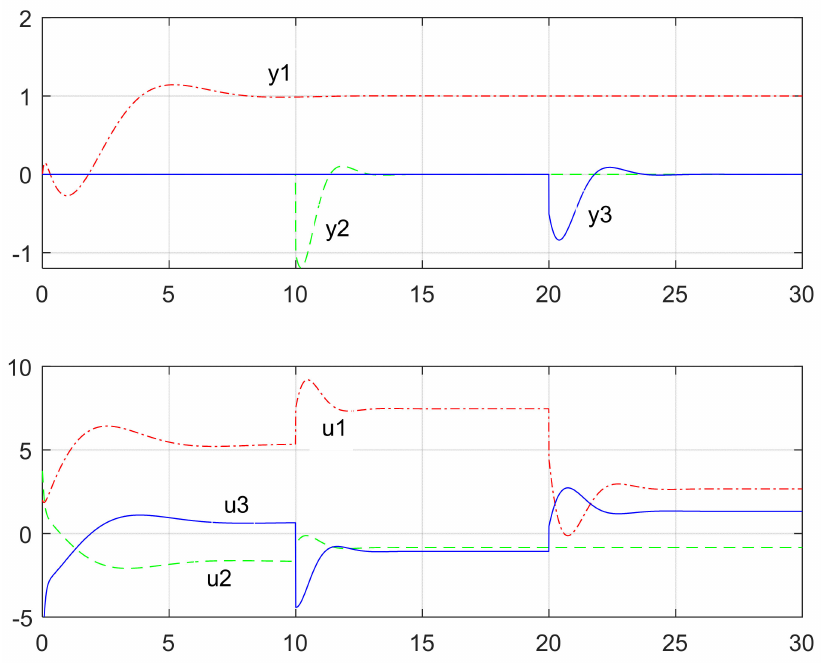
Figure 8. Reference tracking and disturbance regulation with considerate de-coupling. Upper plot shows the system outputs y 1 , y 2 and y 3 as functions of time. Lower plot shows the system inputs u 1 , u 2 and u 3 as functions of time. The references are in Figure 1 are r 1 = 1 and r 2 = r 3 = 0. The output disturbances in Figure 1 are d 1 = 0, d 2 = − σ ( t − 10 ) and d 3 = − 0.5 σ ( t − 20 ) , where σ ( t ) is the unit step function (rather distribution) at time t =